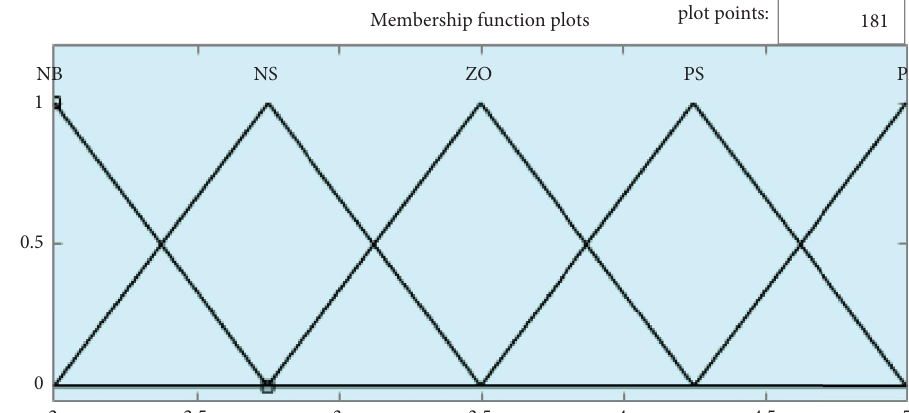
, ∆ k , and ∆ k p i d . p .